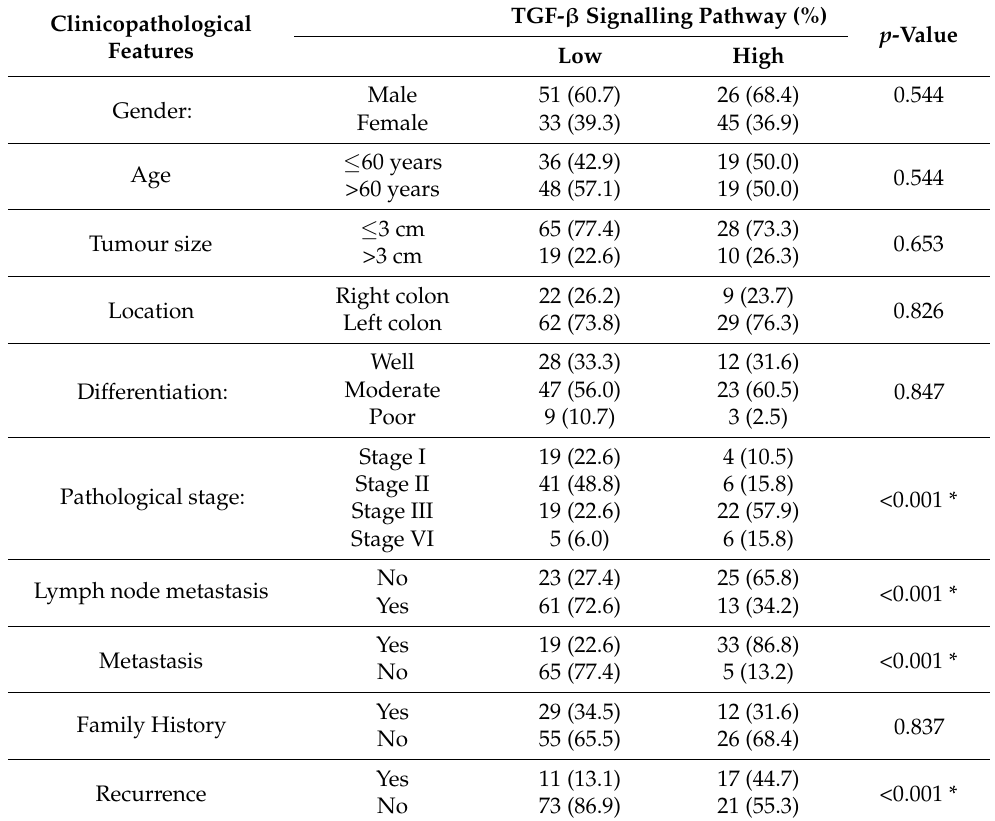
Table 3. Relationship between the expression of TGF- β signalling pathway and clinicopathological